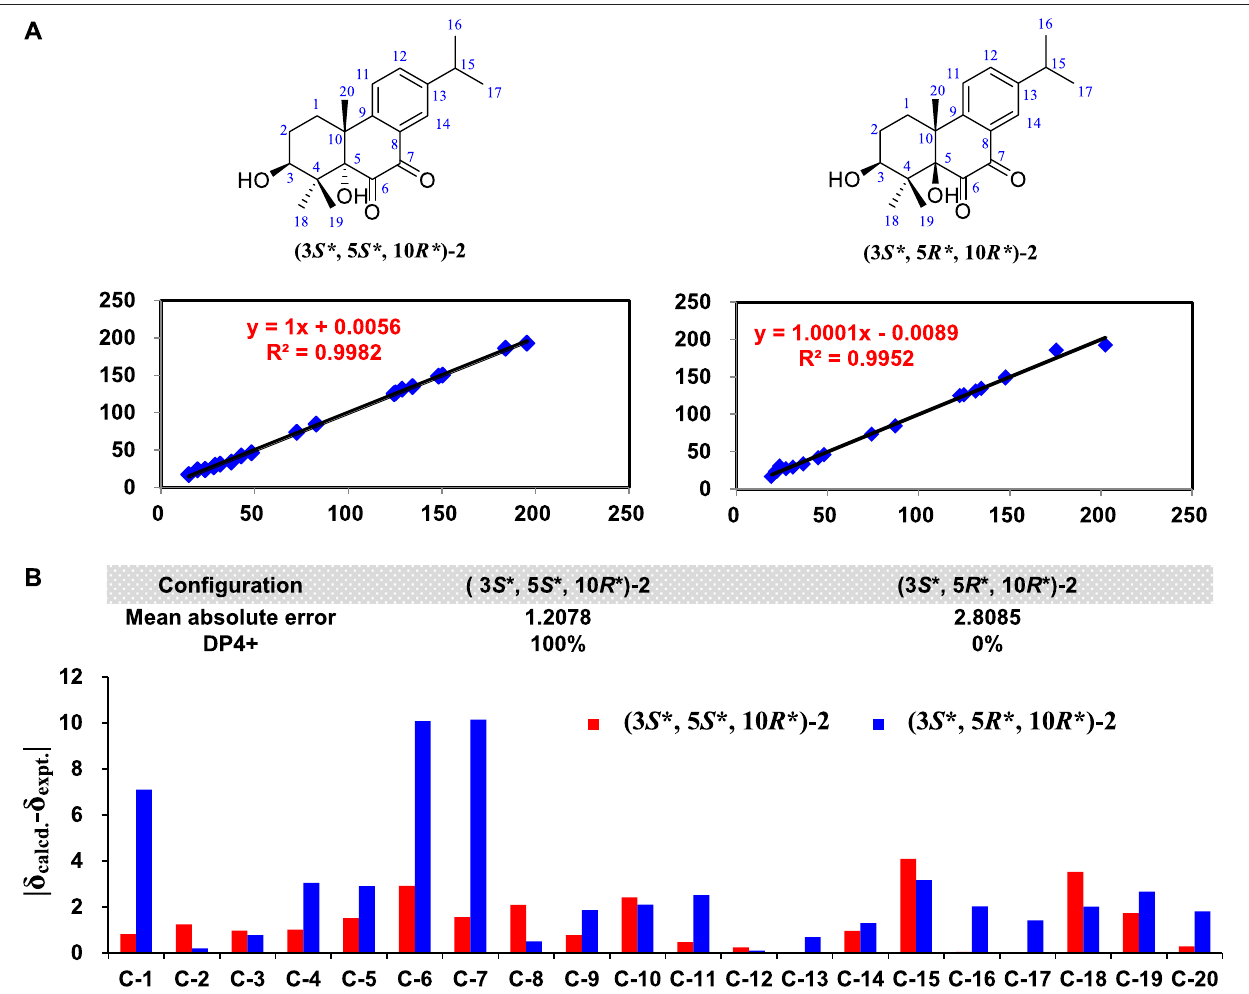
FIGURE 4 | The 13 C NMR calculation results of two plausible stereoisomers of 2 at B3LYP/6-31g+(d, p) level. (A) Linear coerrelation plots of calculated vs. experimental 13 C NMR chemical shift values for two plausible stereoisomers. (B) Mean absolute errors between the calculated 13 C NMR chemical shifts of of two plausible stereoisomers and the experimental 13 C NMR data of 2 and DP4+ probability analysis.